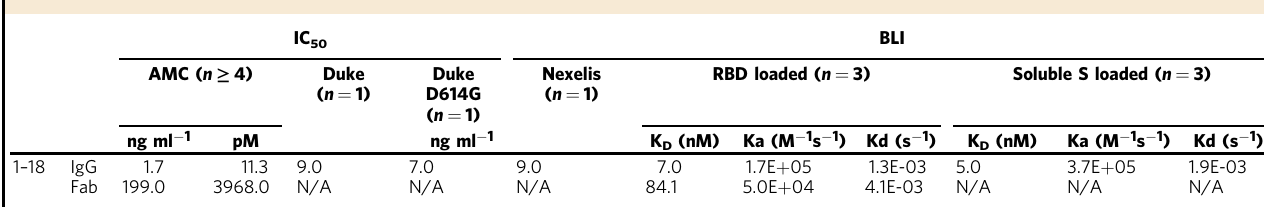
Table 1 BLI and neutralization potency of COVA1-18 IgG vs Fab in HEK293T hACE2 cells. IC